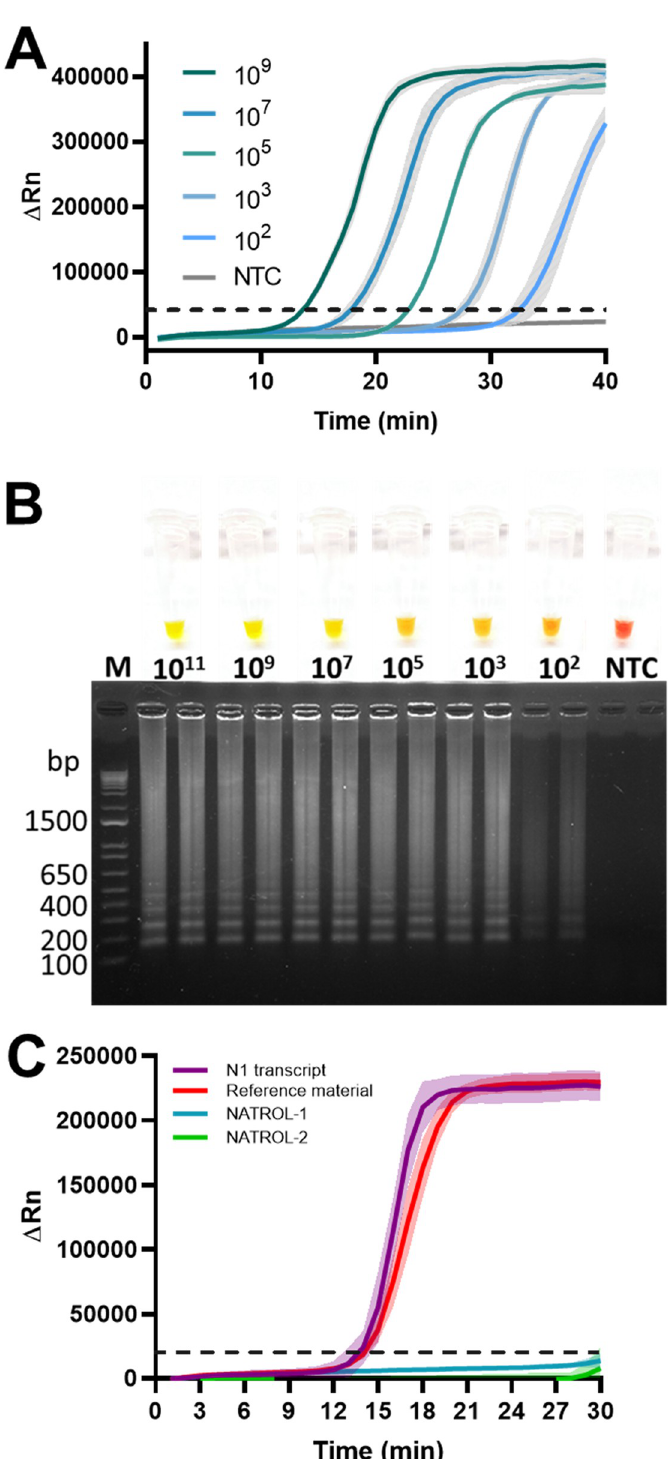
Fig 3. Analytical sensitivity and specificity of RT-LAMP. (A) Real time RT-LAMP amplification plots obtained from ten-fold serial dilutions of in vitro N1 transcript ranging between 10 9 and 10 2 copies/reaction. (B) Colorimetric change and electrophoretic amplifications obtained from ten-fold serial dilutions of in vitro N1 transcript ranging from 10 11 to 10 2 copies/reaction. (C) Evaluation of specificity through the optimized fluorometric real-time RT-LAMP assay with the recombinant Bst and RT enzymes against respiratory controls NATROL-1 and NATROL-2. NTC: non-template